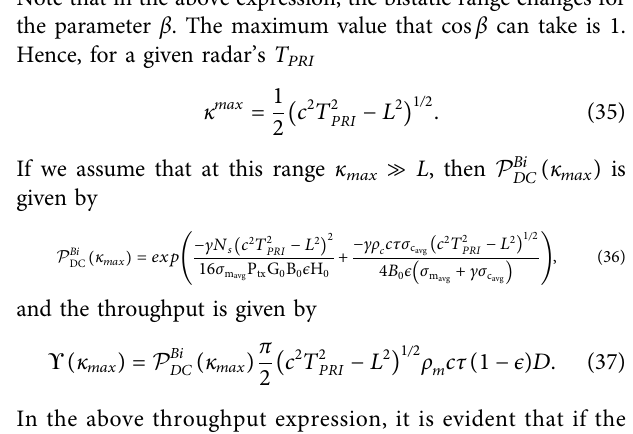
Frontiers in Signal Processing |